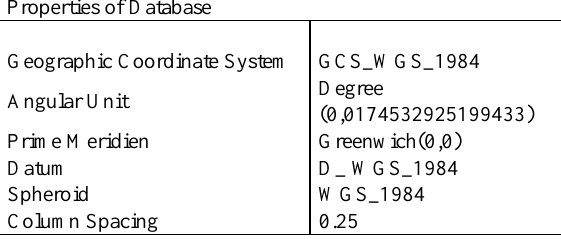
Table 1. Properties of Istanbul Cultural Inventory